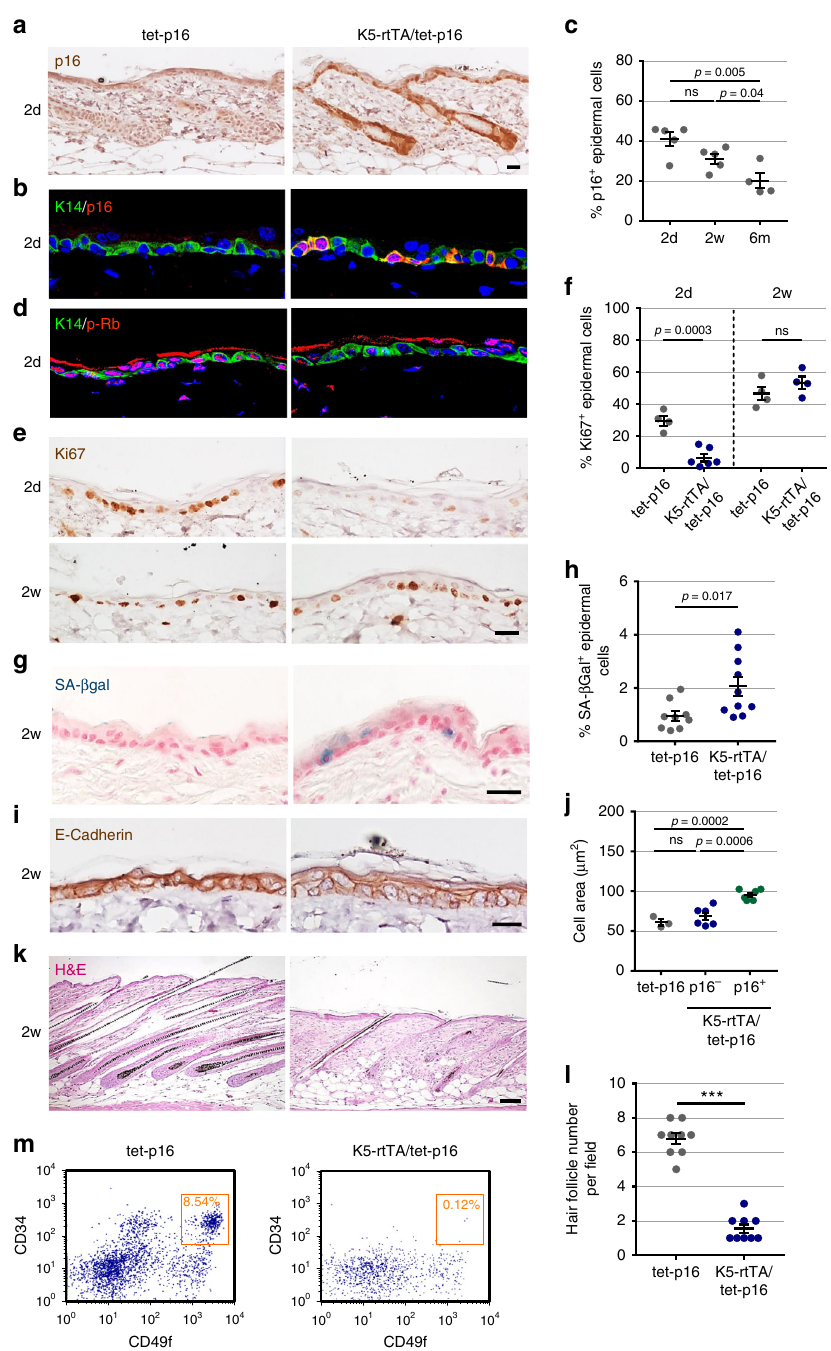
Fig. 1 p16 induces cell-cycle arrest and cell hypertrophy, and disrupts hair-follicle growth. a Immunostaining of human p16 (brown) in back skin sections of K5-rtTA/tet-p16 and control tet-p16 mice treated with doxycycline (dox) for 2 days (2d) starting at 3 weeks of age. b Skin sections from the same mice stained for p16 (red) and K14 (green), which labels the basal epidermis. c Percentage of p16 + keratinocytes in the interfollicular epidermis (IFE) in mice treated with dox for 2 days (2d), 2 weeks (2w), or 6 months (6m). Dots indicate individual mice, n = 5, 5, 4 in respective groups. d Skin sections from mice treated with dox for 2 days, stained for Rb phosphorylated on Thr-821/826 (p-Rb) (red) and K14 (green). e Immunostaining of the proliferation marker Ki67 (brown) in sections from mice treated with dox for 2 days (2d) or 2 weeks (2w). f Percentage of IFE keratinocytes expressing Ki67 in the same mice (dots). n = 4, 6, 4, 4. g SA- β Gal staining (blue) of skin sections from indicated mice, treated with dox for 2 weeks. h Percentage of SA- β Gal positive IFE cells from indicated mice (dots) treated with dox for 2 weeks. n = 9, 10. i Skin sections from indicated mice stained for E-Cadherin (brown) to indicate cell circumference. j Area of epidermal keratinocytes from indicated mice (dots). Shown are values for control mice (tet-p16), and for p16 − and p16 + keratinocytes in K5-rtTA/tet-p16 mice. n = 3, 6, 6 mice, >60 cells were scored per mouse. k H&E-stained skin sections from the indicated mice treated with dox for 2 weeks, showing hair-follicle morphology. l Number of hair follicles per fi eld in indicated mice (dots), following dox treatment for 6 months. n = 9 per group. m FACS analysis of epidermal cells from indicated mice treated with dox for 6 months, stained for CD34, CD49f, and Sca1. Charts show Sca1 − (follicular) cells only. Gate indicates percentage of CD34 + /CD49f high hair-follicle stem cells. Cells were pooled from three mice per group. All graphs indicate mean across mice±S.E.M, all scores were conducted visually from images. Blue labels DNA in all fl uorescence images. *** P <0.0001, t test. ns non-signi fi cant. Scale bars — 20 μ m, except k — 100 μ